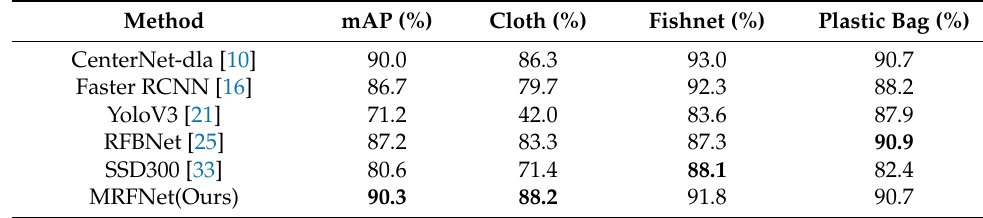
Table 3. Comparison of prediction accuracy on our collected dataset (the best result is bolded). Method